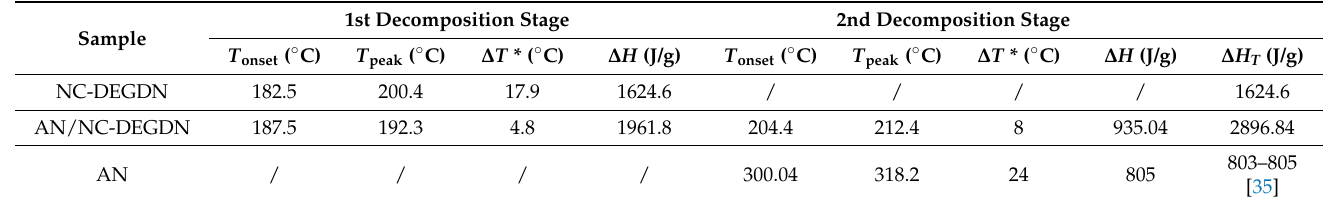
Table 1. Thermal characteristics of the investigated energetic composites obtained at a heating rate of β = 10 ◦